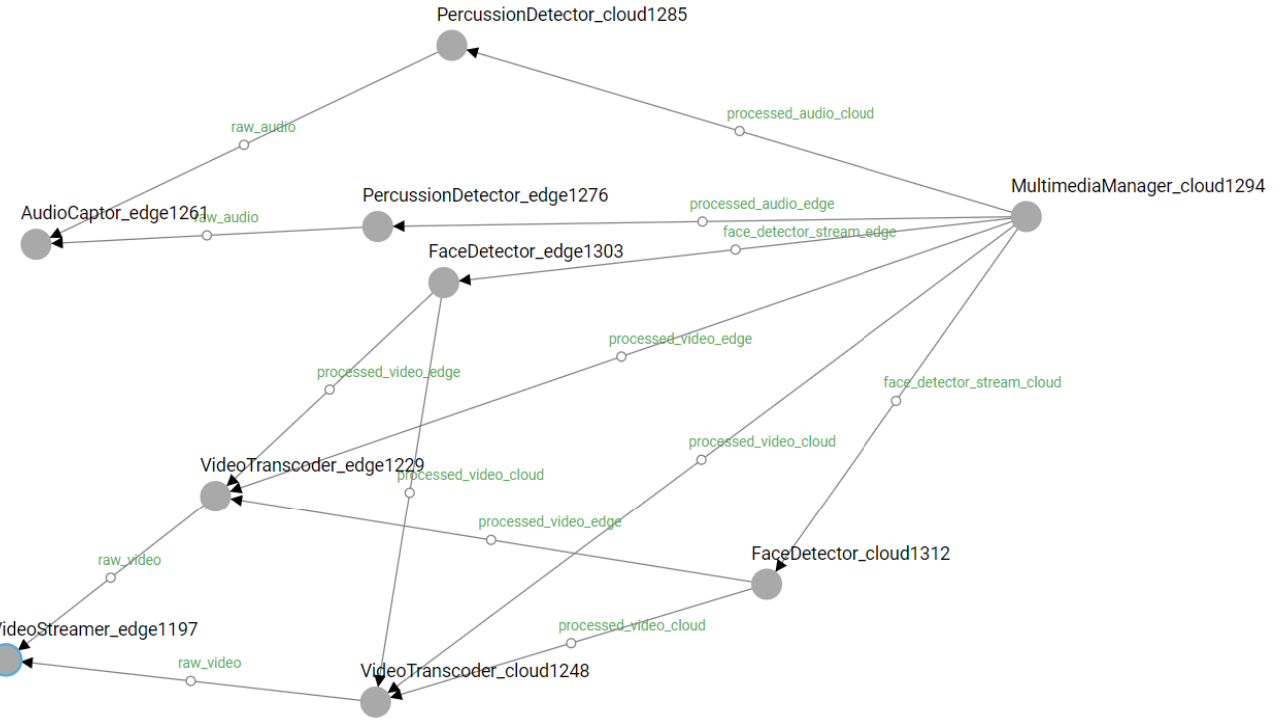
Figure 1. The deployment graph for the illustrative example. The green text on each line indicates the name of the interface between two components (relevant only for the user interface). The requirements for each fragment are listed in Table